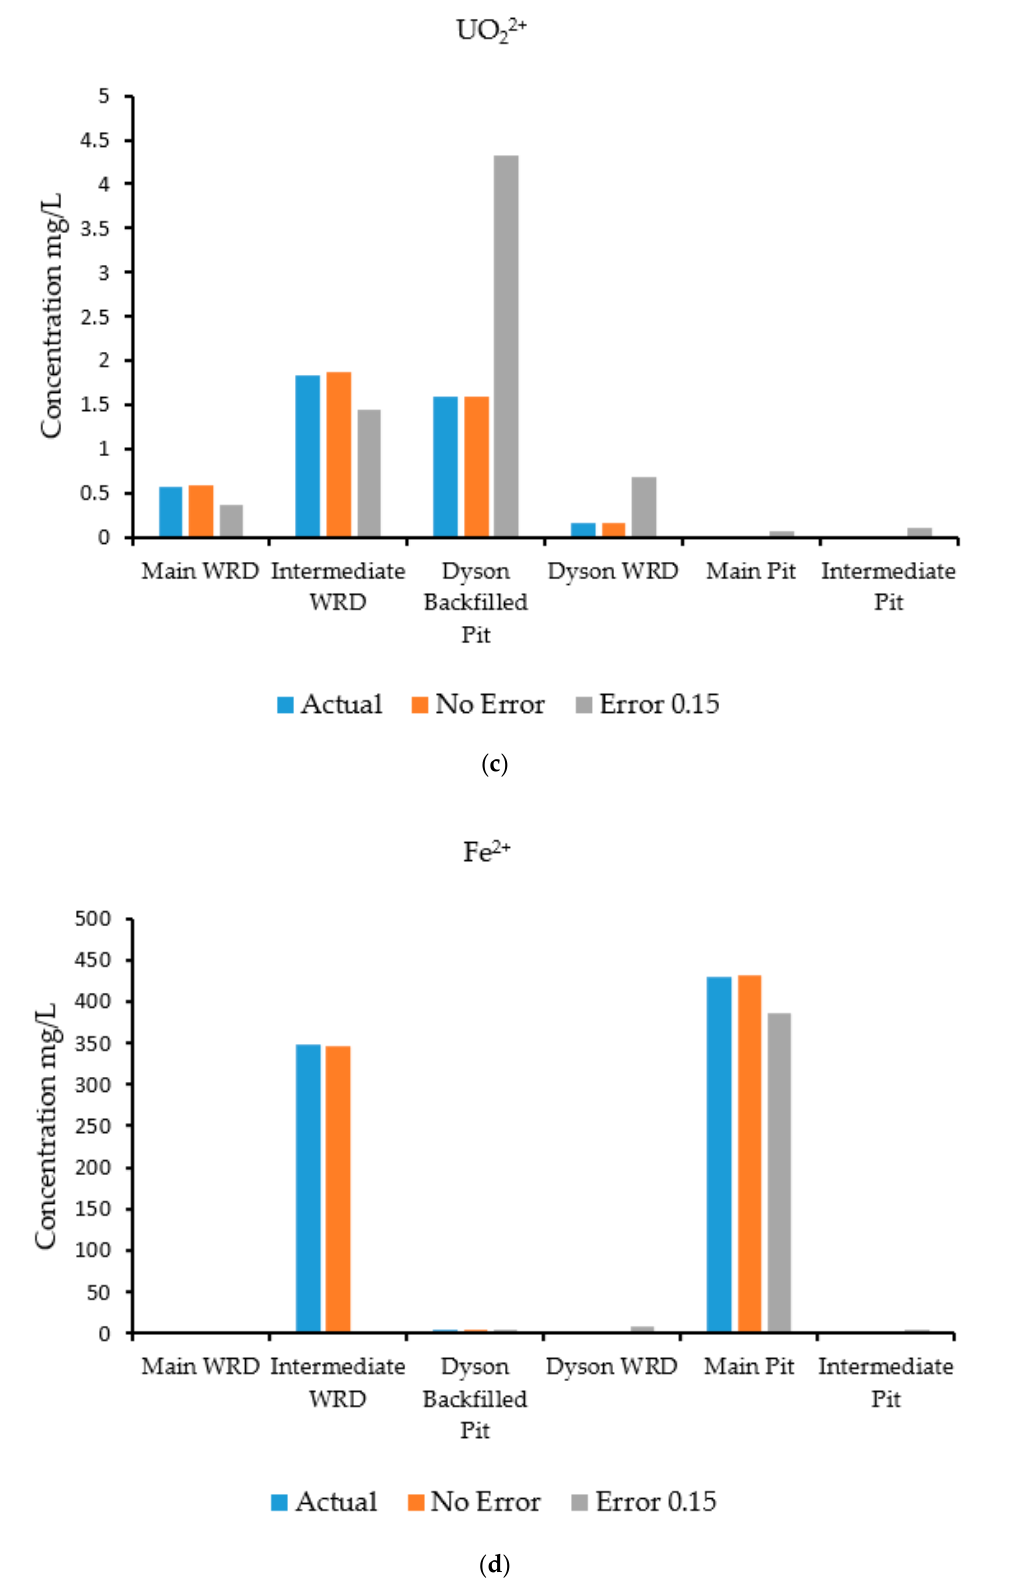
Figure 12. Comparison of species concentrations at sources with a perturbed error of 0.15: ( a ) Cu 2+ species; ( b ) SO 42- species; ( c ) UO 22+ ; ( d ) Fe 2+ species.